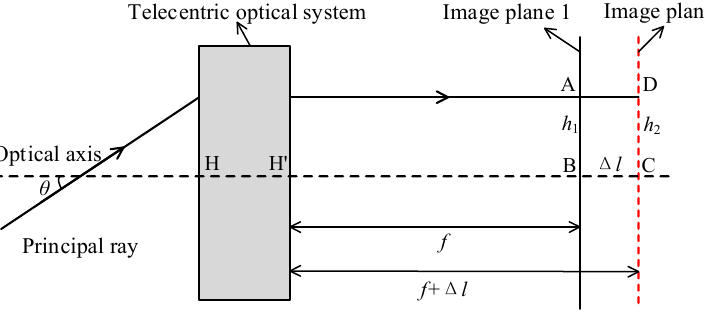
Figure 4. Imaging principle diagram of the telecentric optical system.